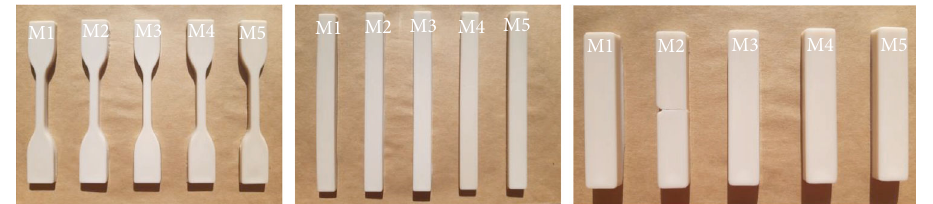
Figure 1: Tensile, fl exural, and unnotched impact testing samples.